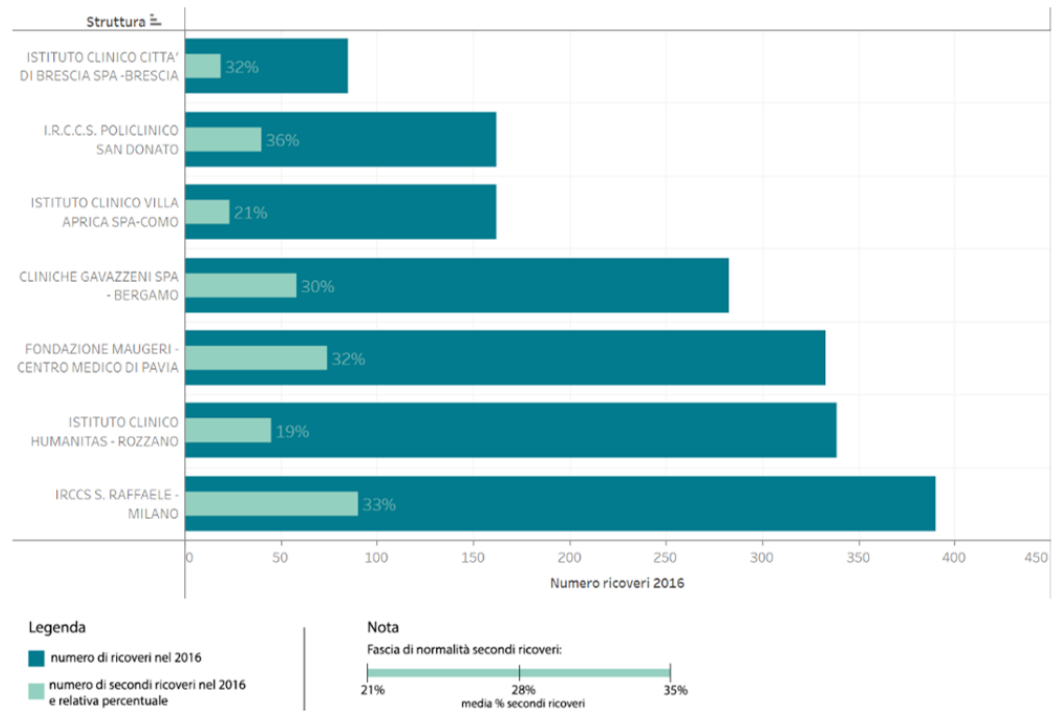
Figure 2. Bar chart showing number of inpatients stays (length of dark-green bars) and second inpatients stays (length of light-green bars within larger bars with the corresponding percentage) for the same disease in the same hospital for 2016—names of hospitals listed on the left.